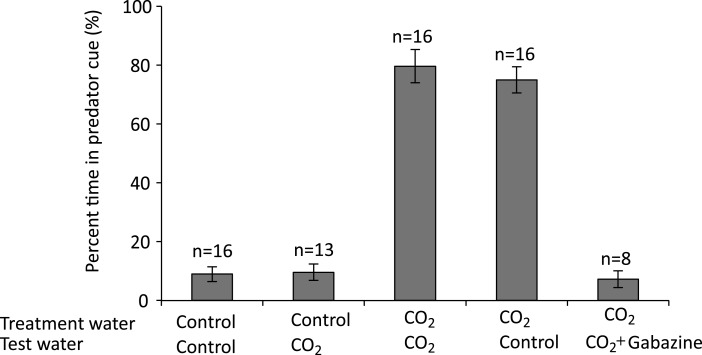
The effect of rearing treatment water (control or high CO2) and test water used in a two-channel flume (control or high CO2) on the olfactory response of larval A. percula to predator cue.One stream of water in the flume contained seawater with predator cue and the other stream of water had untreated seawater. Shown is the percent time (mean ± s.e.) that fish from each experimental combination spent in the water stream containing predator cue. The final group shows fish that were treated with 4 mg l−1 gabazine in high CO2 seawater for 30 minutes before testing in the flume. Sample size shown above the bars.